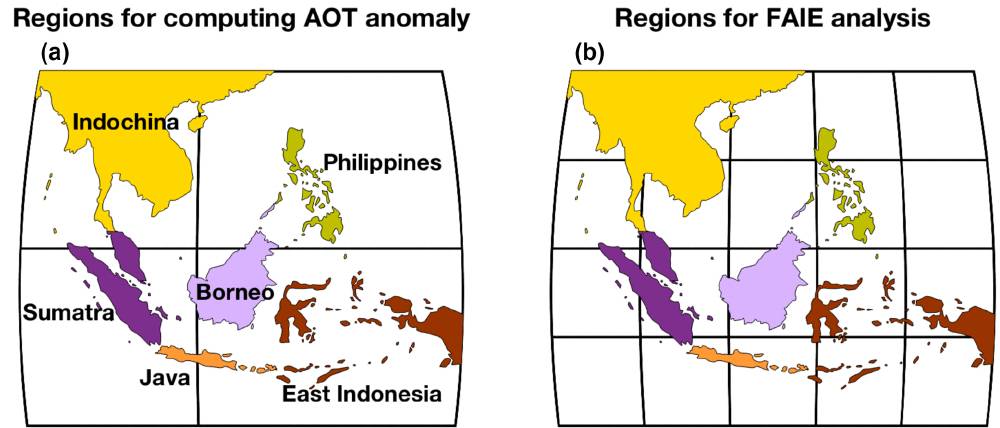
Figure 2. Regions for computing AOD anomaly thresholds (a) and regions for investigating the FAIE (b) . For land, the same regions are used for both AOD anomaly calculations and for the FAIE analysis. For ocean, we perform the FAIE analysis on 20 10 × 10 ◦ grids, but aerosol anomaly thresholds for ocean regions are found using four larger grids, shown in the left plot. Land regions are distinguished with unique colors: Indochina in yellow, the Philippines in green, East Indonesia in dark red, Java in orange, Borneo in lavender, and Sumatra in purple.